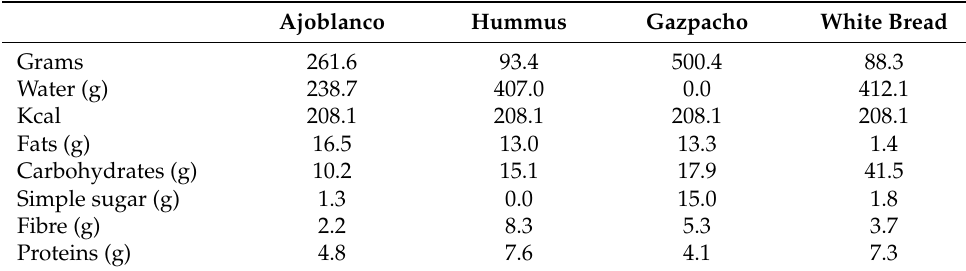
Figure 1. Flow diagram representing the different stages of the study design. Table 1. Description of the preloads tested in the present